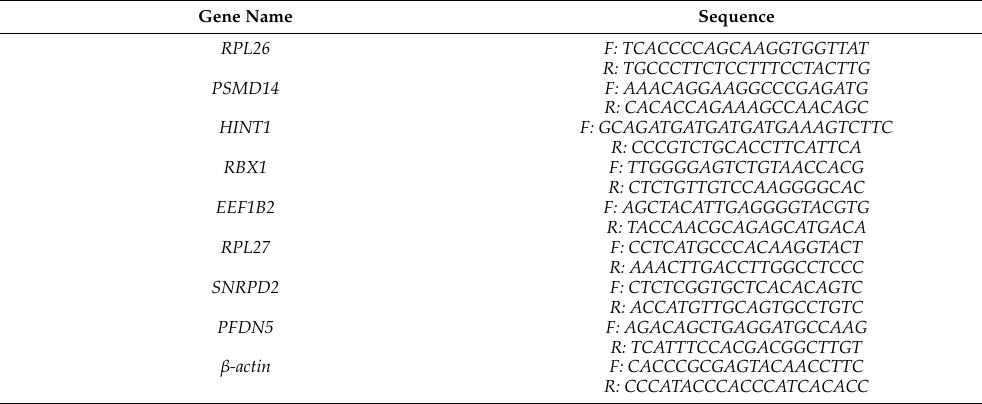
Table 1. Primer sequences.